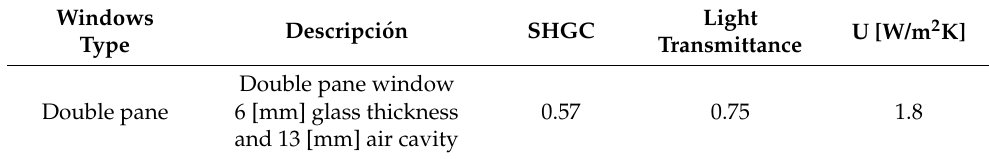
Table 10. Properties of the Low-E windows.